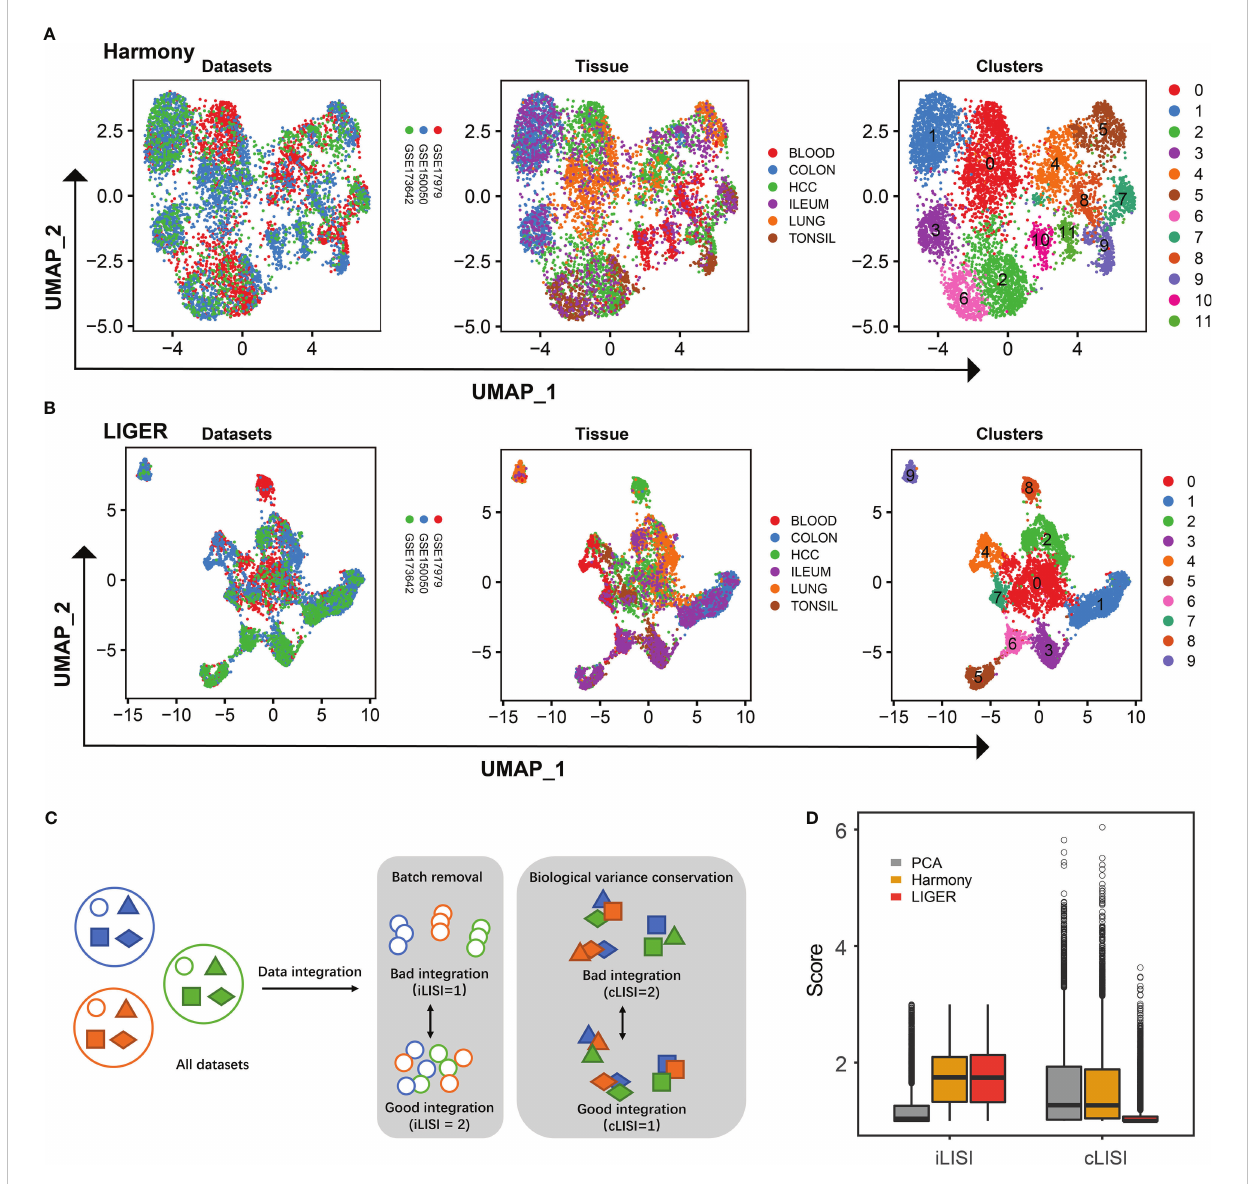
FIGURE 1 Integration of ILCs from three scRNA-seq datasets. (A) UMAP plots showing the integration of three scRNA-seq datasets by Harmony. (B) UMAP plots showing the integration of three scRNA-seq datasets by LIGER. (C) Schematic work fl ow to the quantitative assessment of data integration and batch-correction fi delity. iLISI metrics and cLISI provide measures of the degree of mixing among datasets and integration accuracy on cell types, respectively. (D) Boxplot showing the iLISI and cLISI distribution of data integrated by PCA, Harmony and